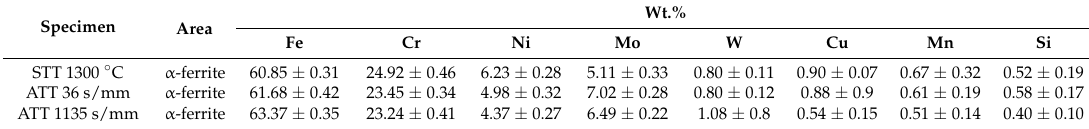
Table 3. SEM/EDX chemical analysis of the α -ferritic matrix. The profile of Ni concentration, with the ongoing of the annealing thermal treatment, testifies the supersaturation of α -ferritic matrix with γ -formers elements, such as Ni, Mn, and Cu.